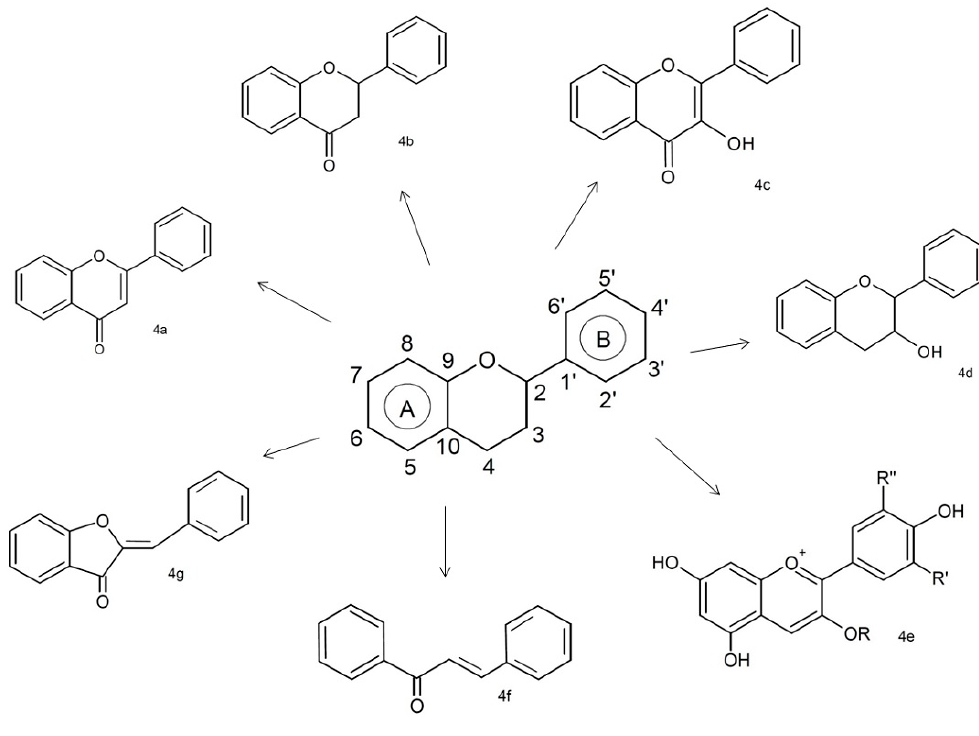
Figure 4. Structures of flavonoids class.